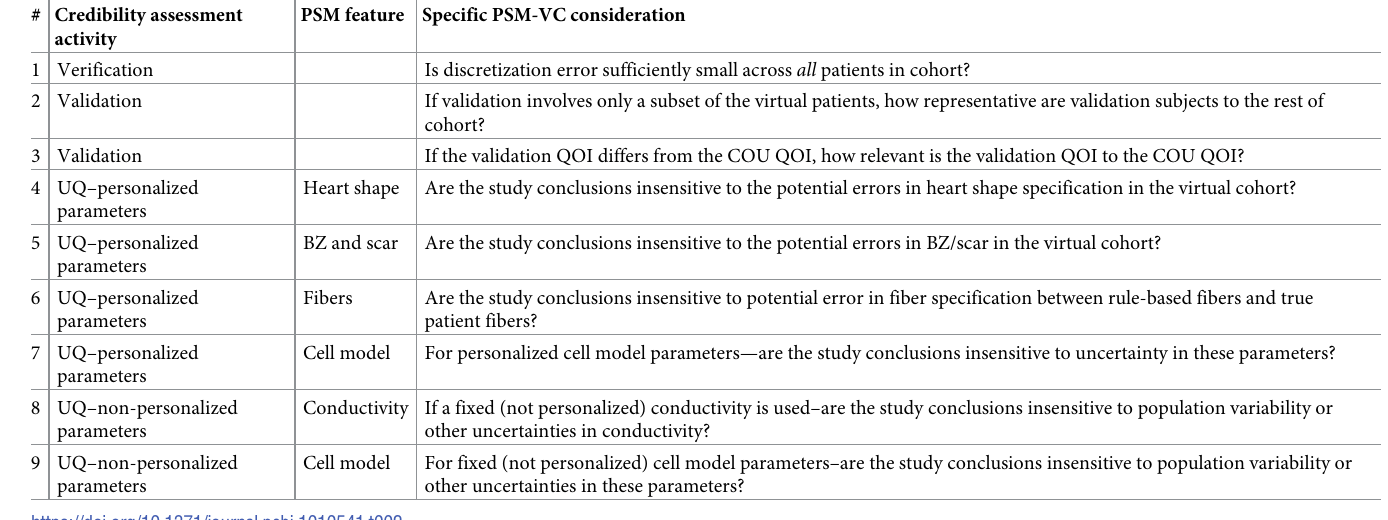
Table 2. Example specific credibility-related considerations for simulation studies that use a virtual cohort of patient-specific models. Acronyms: UQ–uncertainty quantification; QOI–quantity of interest; COU–context of use; BZ–border